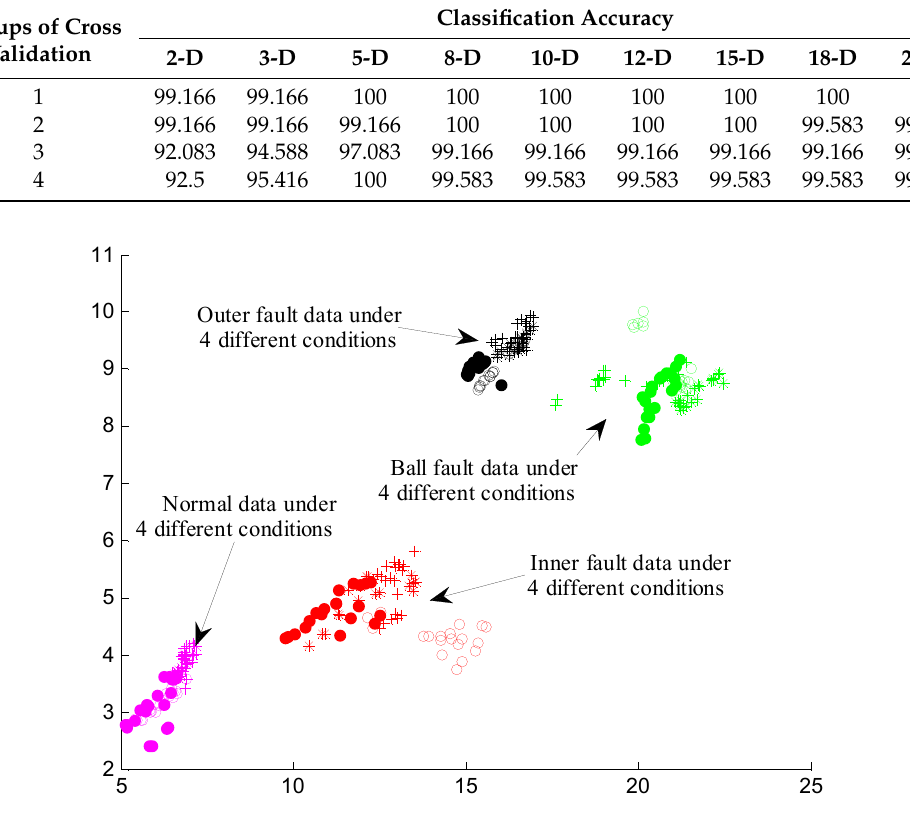
Figure 17. The feature scatter diagram in two-dimensional space.